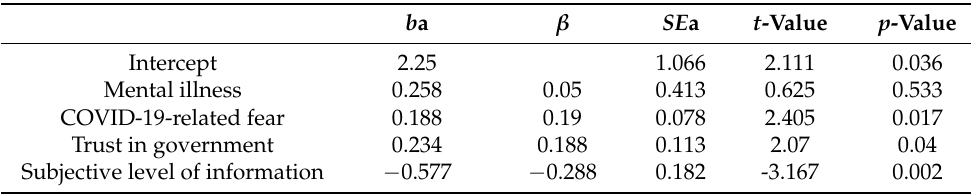
Table 5. Regression coefficients predicting an increase in distress (DT).